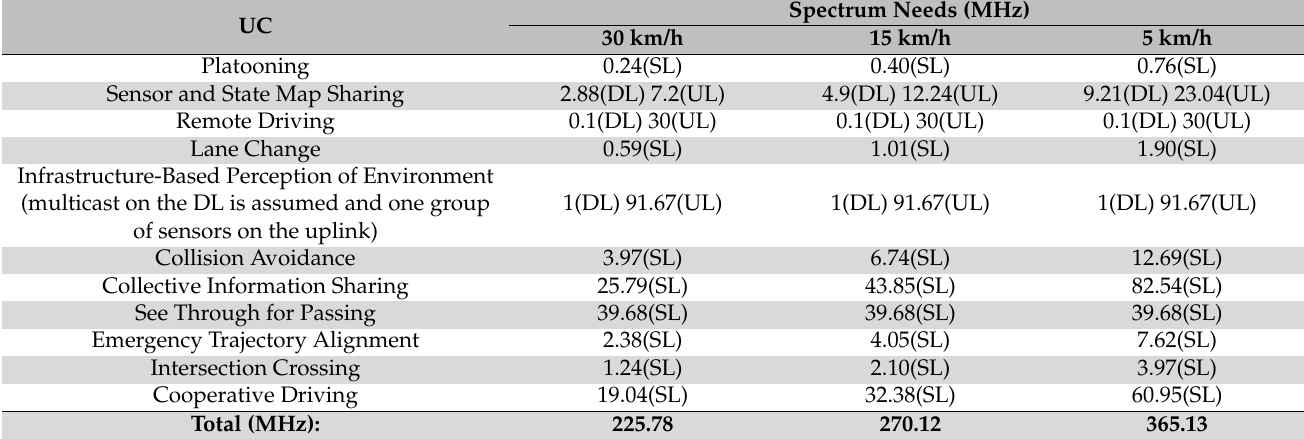
Table 13. Spectrum needs per gNB sector (2 gNBs) in the urban grid